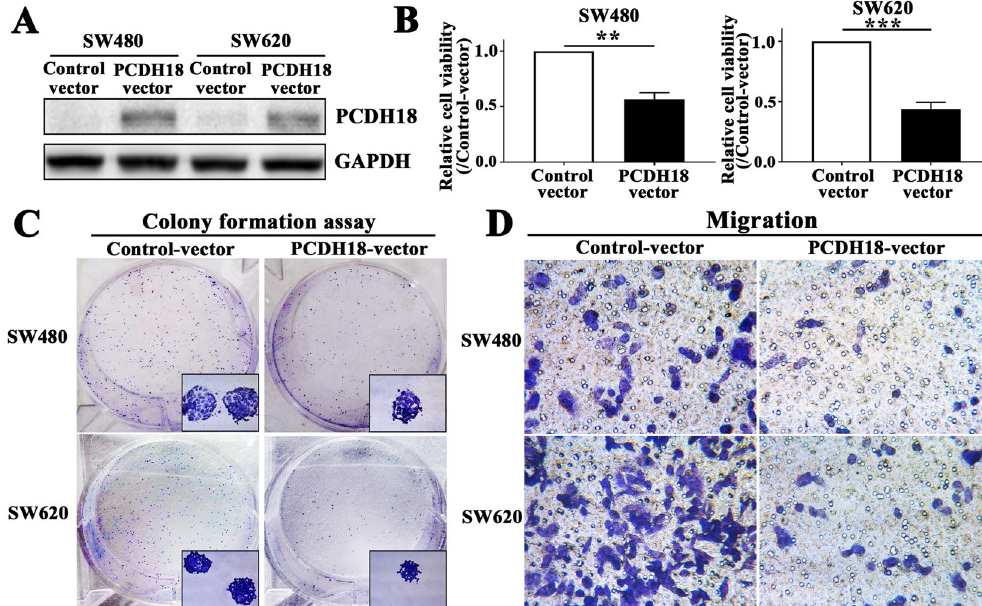
Figure 4. Overexpression of PCDH18 suppresses cell migration and proliferation in CRC cell lines. ( A ) Expression of PCDH18 in SW480 and SW620 cells after transfection with a PCDH18 expression vector was confirmed by Western blot. ( B ) PCDH18 expression significantly suppressed the number of viable cells of PCDH18-transfected SW480 and SW620 cells compared to that of control vector-transfected cells. ( C ) Representative images of colonies in PCDH18-transfecting as well as control vector-transfecting SW480 and SW620 cells. ( D ) Representative transwell assays in PCDH18-transfecting as well as control vector- transfecting SW480 and SW620 cells. Results were shown with means ± SD. * p < 0.05, ** p <